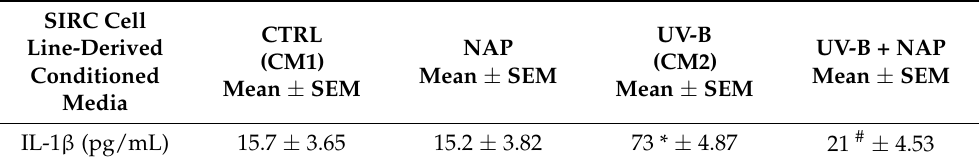
Table 1. IL-1β content in a conditioned medium from SIRC cells. IL-1β levels were detected in supernatants and expressed in pg/mL. Data resulting from three independent experiments are represented as means ± SEM. * p < 0.001 vs. CM1; # p < 0.001 vs. CM2.